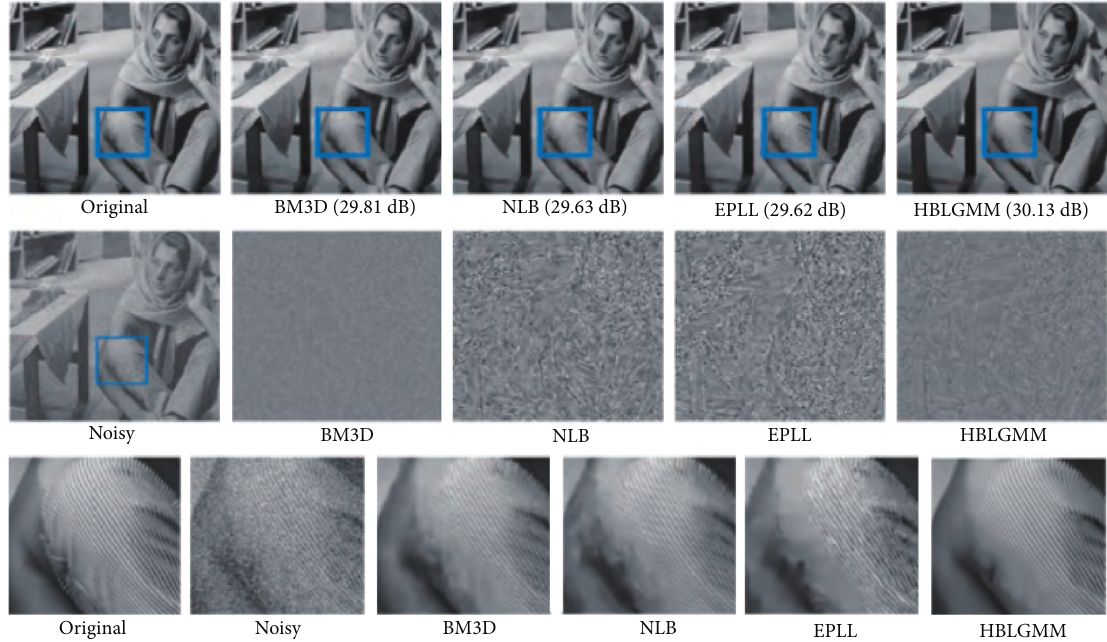
Figure 6: Comparison of the visual quality of denoising.